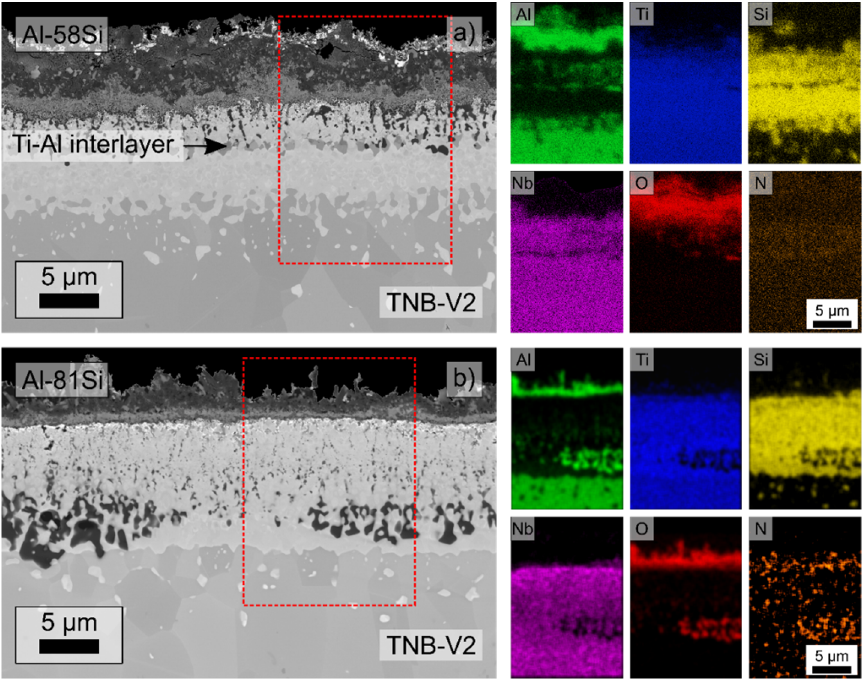
Figure 8. SEM cross sections in the of the Al-58Si ( a ) and Al-81Si ( b ) coatings (all in at.%) after 1000 cycles at 900 °C with the corresponding EDS elemental mappings of the red marked area.